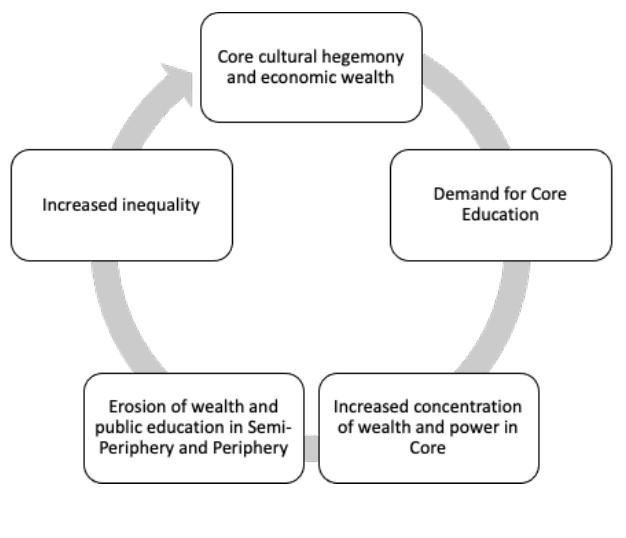
Figure 1: Feedback Loop of International